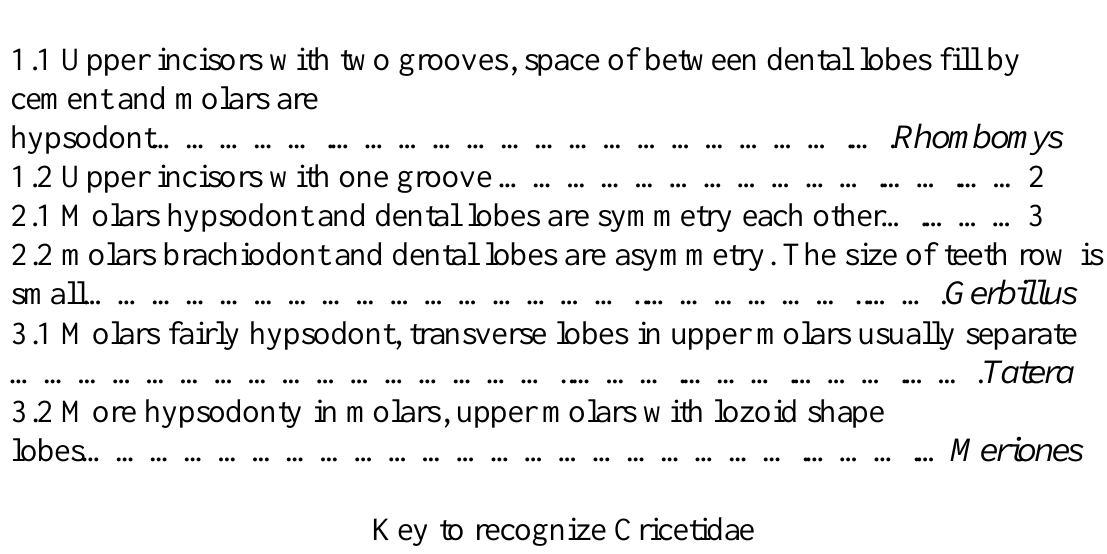
Key to identify subfamily Gerbillinae